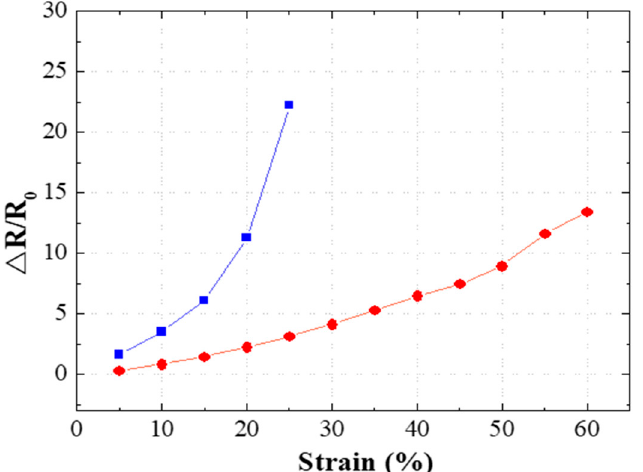
Figure 6. Graph of the resistance change rate of the longitudinally and laterally aligned flexible strain sensors.